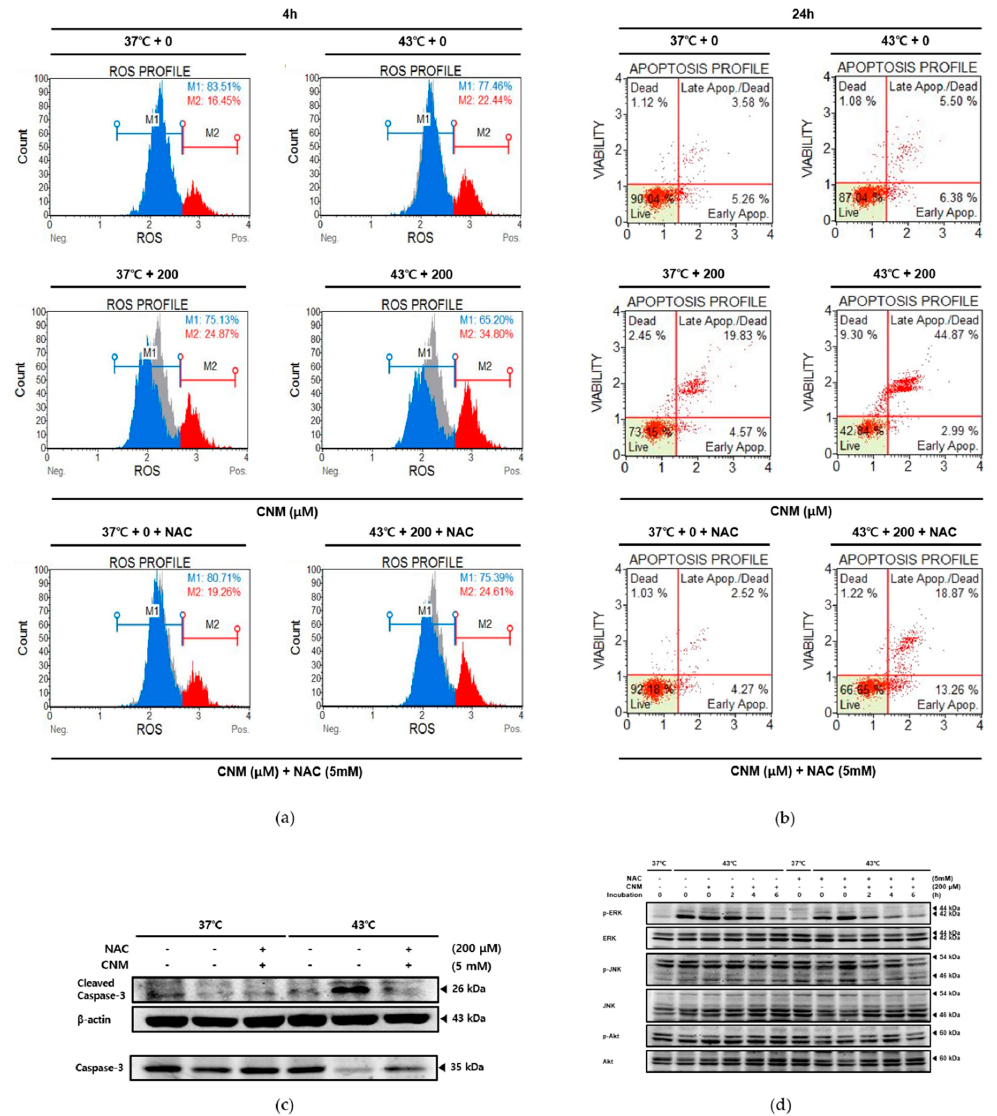
Figure 6. Effect of CNM and hyperthermia combination therapy on ROS generation, apoptosis markers and MAPK pathway in ROS-inhibited A549 cells. A549 cells were pre-treated with N-acetylcysteine (NAC) and then treated with CNM (0 or 200 μ M) with or without hyperthermia and incubated for the indicated time. Flow cytometry analysis on ( a ) ROS generation and ( b ) apoptosis profile was performed. β -actin was used as a loading control. Protein expressions of ( c ) caspase-3, caspase-9, ( d ) p-ERK, ERK, p-JNK, JNK, p-Akt and Akt were measured using Western blot assays. Representative blots are shown. ( − ), absence of NAC or CNM; (+), presence of NAC or CNM.